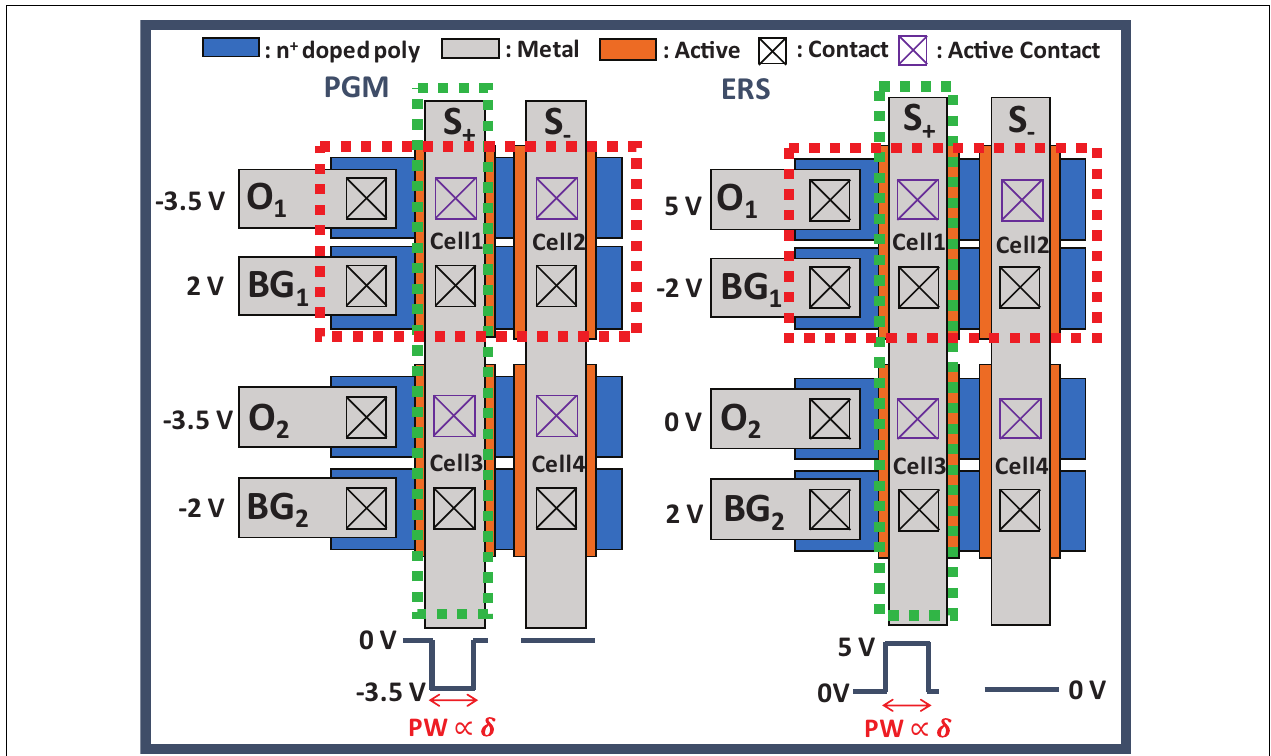
FIGURE 4 | Bias condition in the update phase with the GSD array. The red dotted square is the condition along the BG and O line for S (T) of 1, and the green dotted square along the S line is the condition when δ is not equal to 0.